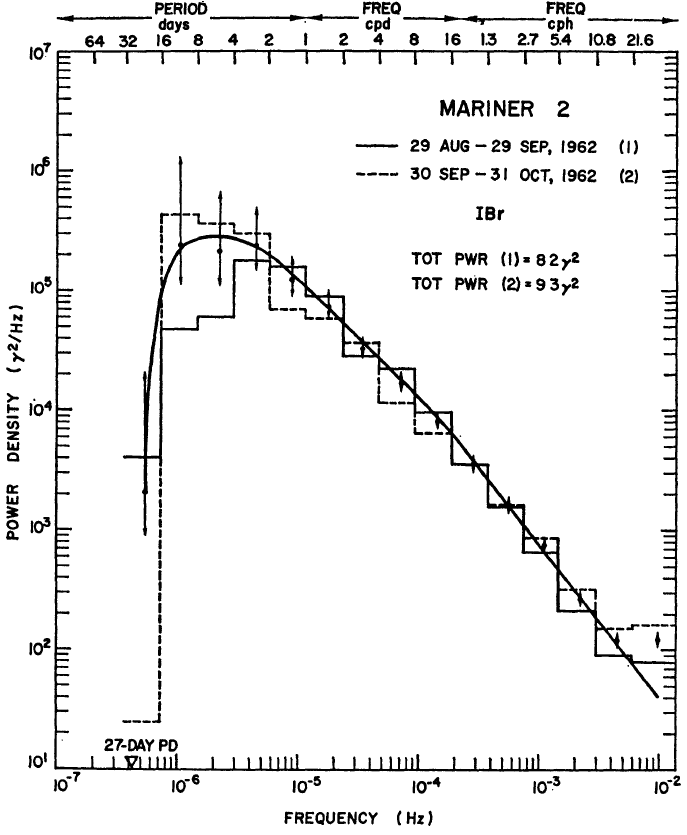
Figure 20: The magnetic energy spectrum as obtained by Coleman